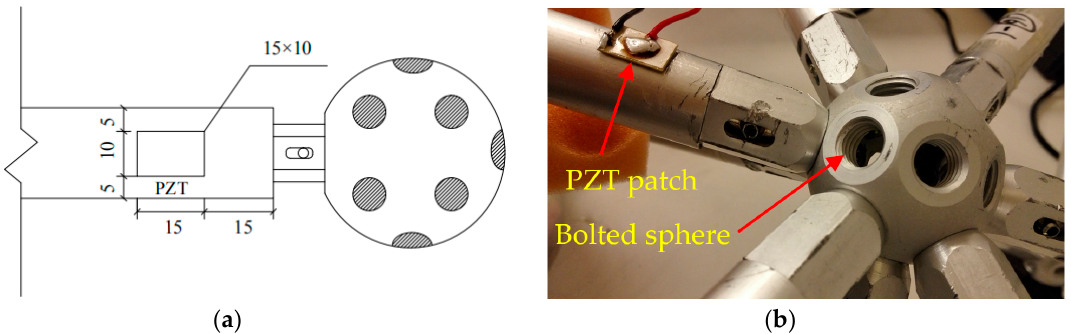
Figure 6. ( a ) Detailed dimension of the location of PZT patch (unit: mm); ( b ) Photo of the location of PZT